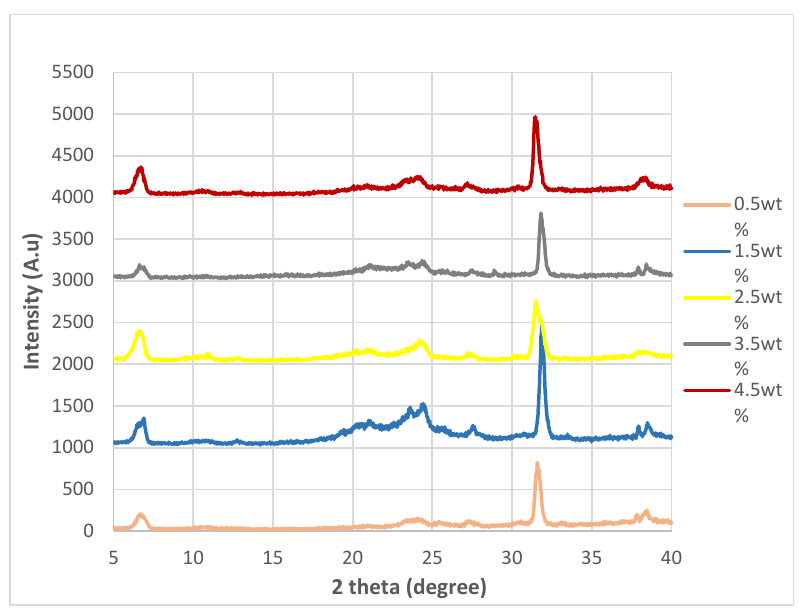
Figure 4. XRD Spectra of Nylon 610 Nanocomposites with Graphite Nanosheets Treated at 200 °C and − 0.1 MPa.